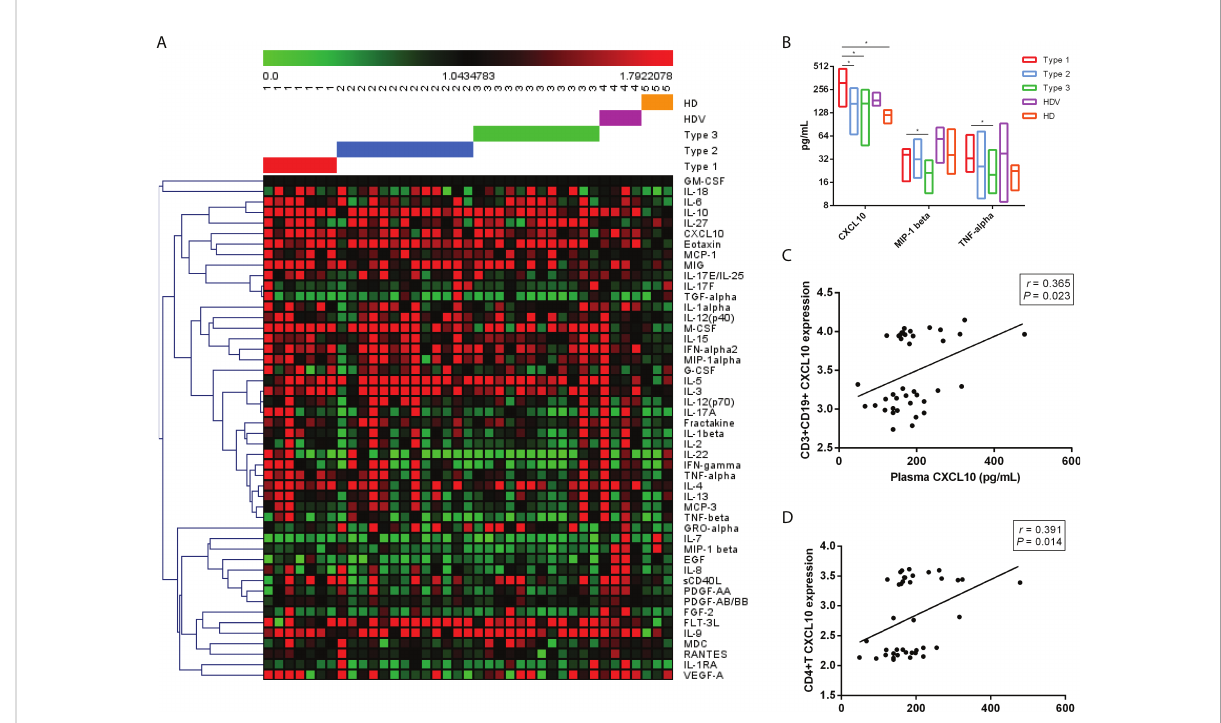
FIGURE 5 Plasma cytokine/chemokine/growth factor levels after two-dose vaccination in LT recipients. (A) Heatmaps representing the 48 cytokine/ chemokine/growth factor levels among the Type 1, Type 2, Type 3, HDV, and HD groups. (B) Higher concentrations of plasma CXCL10, MIP-1 beta, and TNF-alpha in Type 1. Correlation between plasma CXCL10 level and CD3+ CD19+ CXCL10 expression (C) and CD4+ CXCL10 levels (D) . p -Values (two-sided) and r values are based on Spearman ’ s rank test. LT, liver transplant; HDV, healthy donors vaccinated with the inactivated vaccine; HD, healthy donors without vaccination. *p <